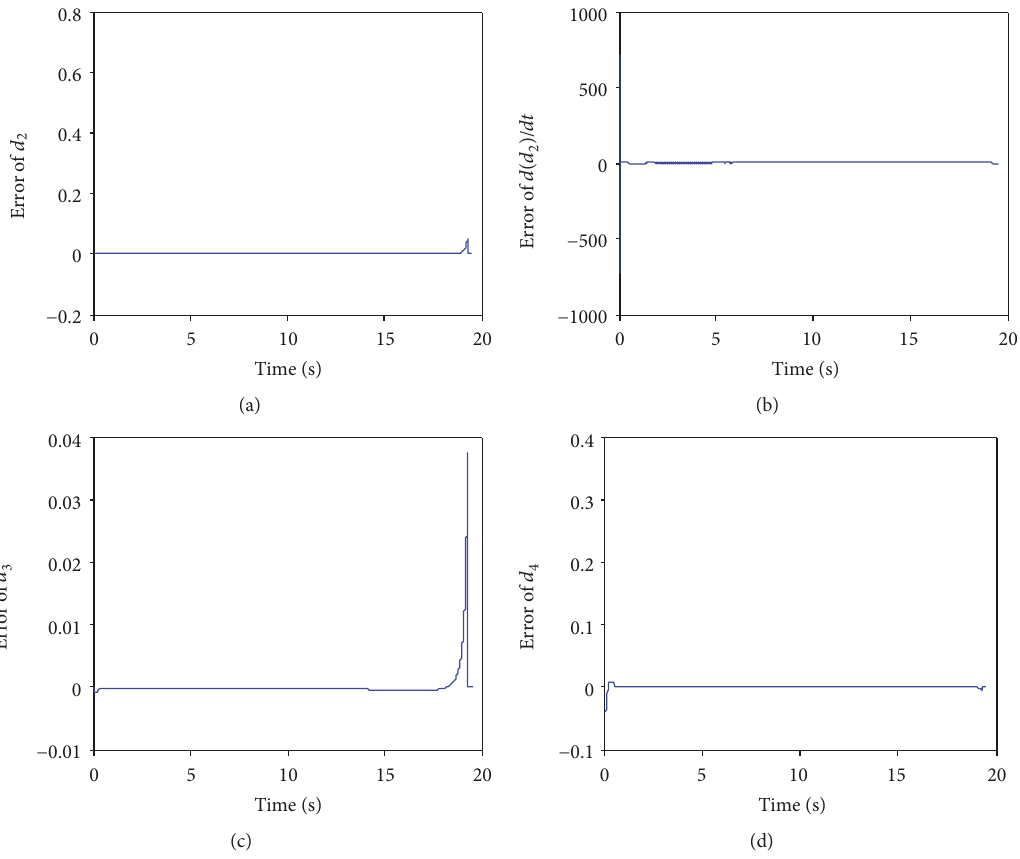
Figure 3: Estimate curves of uncertainties under the nonlinear disturbance observer.